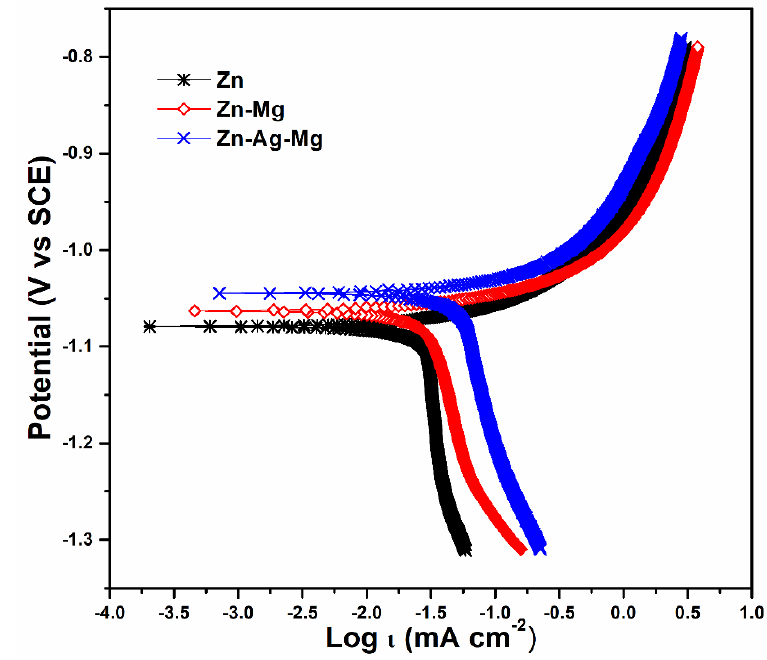
Figure 12. Polarization curves of the extruded alloys exposed to the NaCl solution at physiological concentration (T = 37 °C and pH = 7.4).